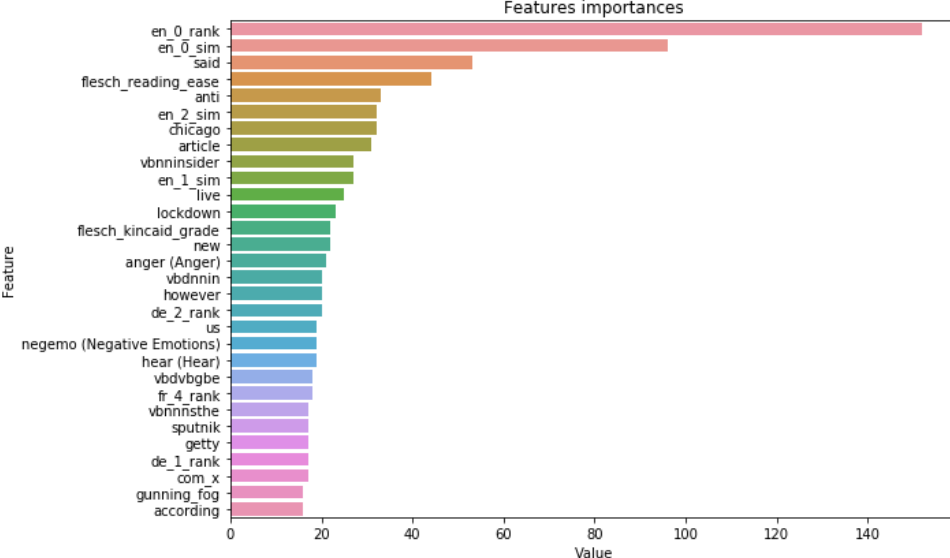
Figure A2. Top 30 feature importances of the best model for the ReCOVery dataset: LightGBM model based on Ngrams + CE Emb. + Rank feature